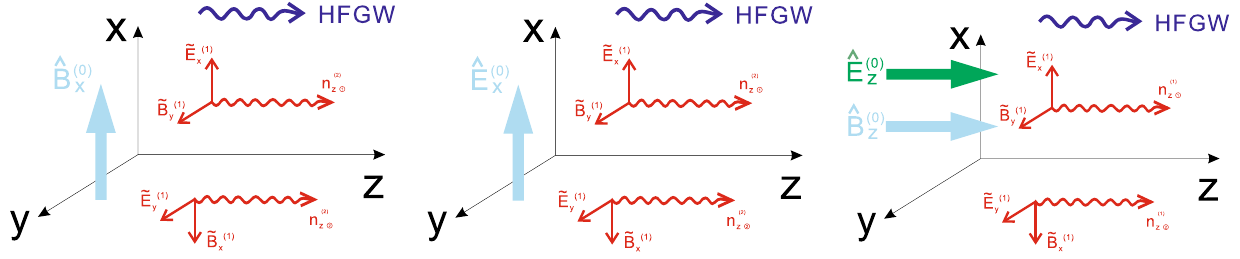
( 2 ) ( 2 ) and n , z 1 (cid:9) z 2 (cid:9)